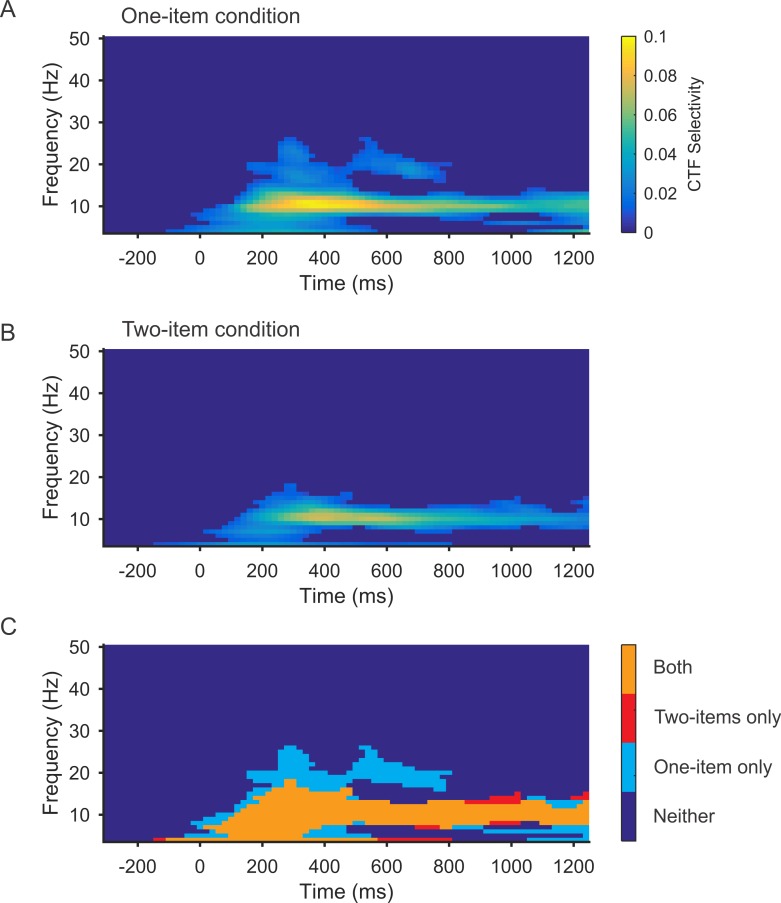
Identifying frequencies that track remembered positions during one-item and two-item maintenance.(A–B) Selectivity of spatial CTFs (measured as CTF slope) reconstructed from the scalp distribution of oscillatory power across a broad range of frequencies for the one-item (A) and two-item (B) conditions. Points with no reliable CTF selectivity as determined by the cluster-corrected permutation test are set to dark blue. (C) Overlay plot marking the clusters of reliable selectivity in the one-item condition (light blue), two-item condition (red), and both (orange). Data are available at https://osf.io/47cmn/. CTF, channel-tuning function.